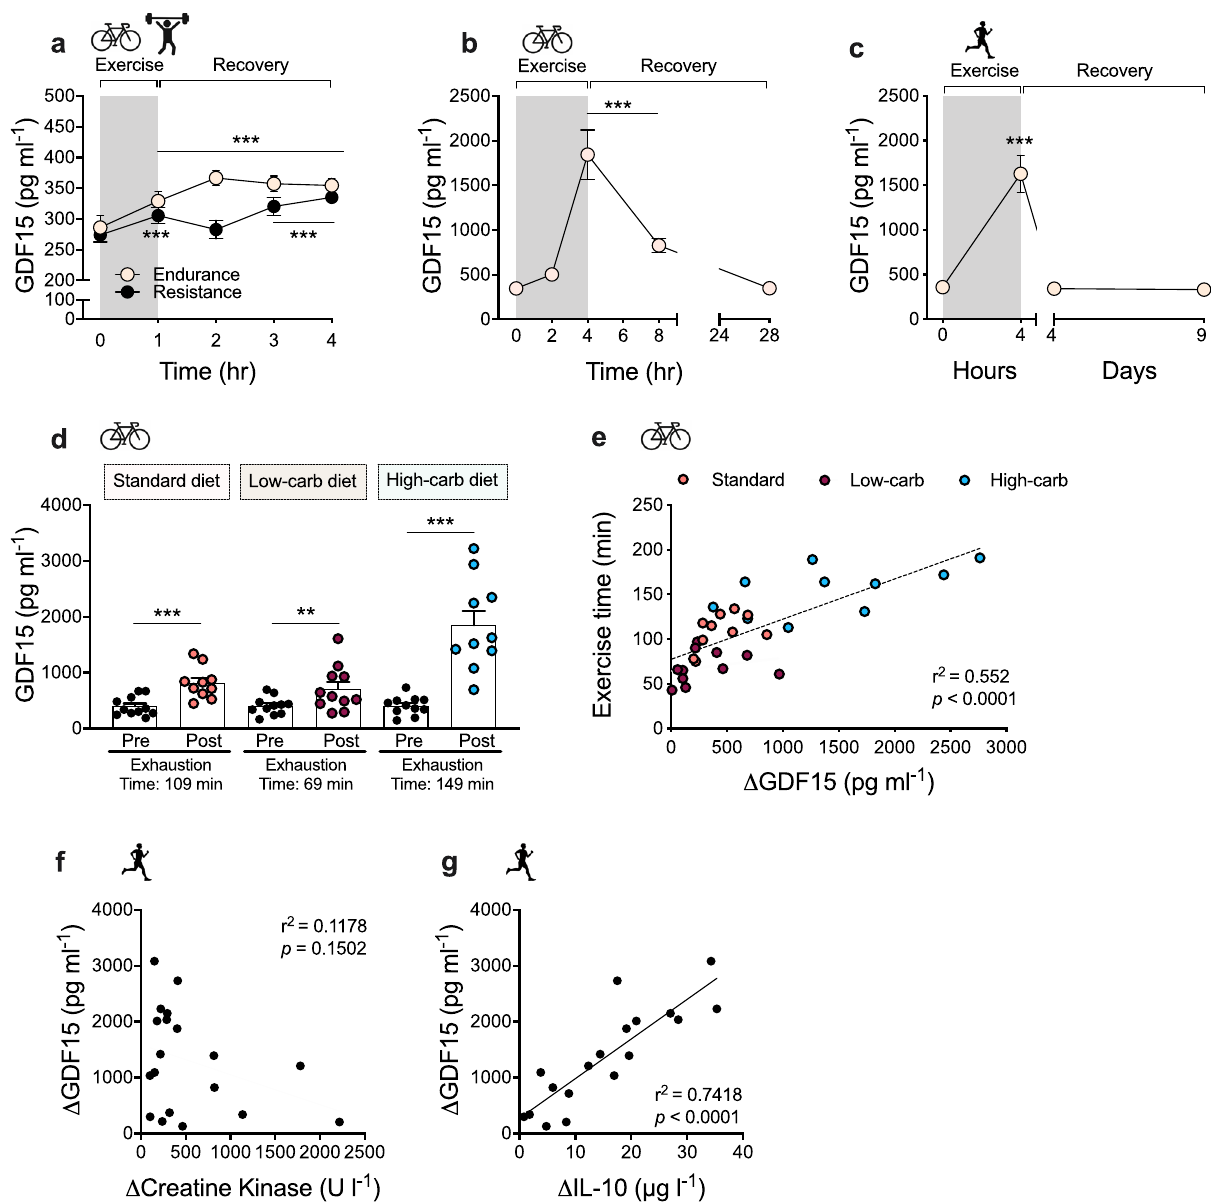
Fig. 1 Effect of exercise on circulating GDF15 in humans. a Plasma GDF15 values before and after 1 h of high-intensity resistance ( n = 10) or vigorous endurance exercise ( n = 10) and at indicated time points during recovery ( p < 0.001). b Plasma GDF15 levels were measured in highly trained elite male triathletes ( n = 15) bicycling at 73 ± 1% of maximal heart rate (HR max ) for 4 h, with blood sampling as indicated immediately before, during, and in recovery from exercise ( p < 0.001), with one missing value at 28 h. c Plasma GDF15 levels measured before and after a marathon (42.195 km); completing time was 243 ± 8 min [mean ± SEM] (4 h on the fi gure), with additional measurements of GDF15 on day 2 – 5 ( p < 0.001) and day 9 – 10 after the marathon (on day 4 and day 9) ( n = 20). d On three separate occasions, under three different dietary regimes as indicated, subjects performed cycling exercise at 75% of maximal oxygen uptake (VO 2max ) until exhaustion. GDF15 plasma levels were measured pre-exercise and at exhaustion on each occasion ( n = 11; standard diet, p < 0.001; low-carb diet, p = 0.0064; high-carb diet, p < 0.001; one missing value in the high-carb group post-exercise). e Relationship between change in GDF15 values ( Δ GDF15) and time to exhaustion for the diet-exercise interventions presented in d . f Relationship between change in GDF15 values ( Δ GDF15) (from c .) and Δ creatine kinase pre vs. post marathon. g Relationship between change in GDF15 values ( Δ GDF15) (from c ) with Δ IL-10 plasma values pre vs. post marathon. Data are presented as mean ± SEM, * P < 0.05; ** P < 0.01; *** P < 0.001 compared to time-point 0 or as indicated. a Repeated measures two-way ANOVA with Bonferroni multiple comparisons test. b and c Repeated measures One-way ANOVA relative to starting time, d Two-tailed paired t tests for each exercise – diet trial. Source data are provided as a Source Data fi